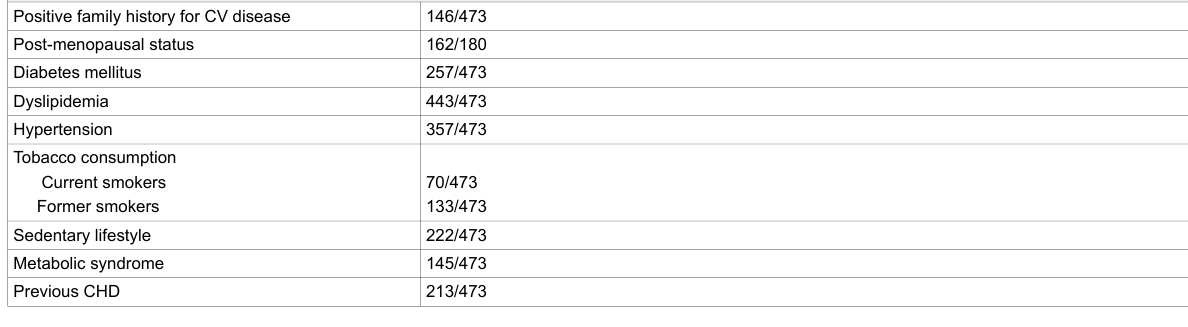
Table 4: Lipid profile alterations found in the study population with high cardiovascular risk.